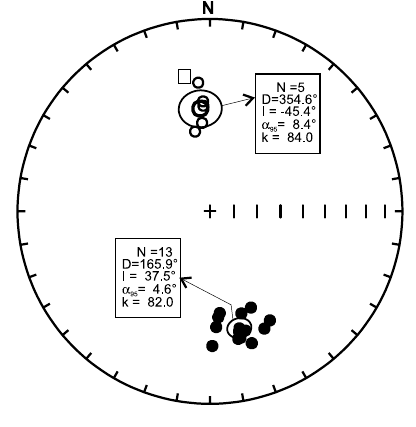
Fig. 8 – Equal area projection of site-mean magnetization direc- tions of normal and reversed polarity of the Botucatu samples. Solid (open) circles are positive and negative inclinations; square correspond to the local geomagnetic field. Ovals indicate the 95% confidence limit of the mean